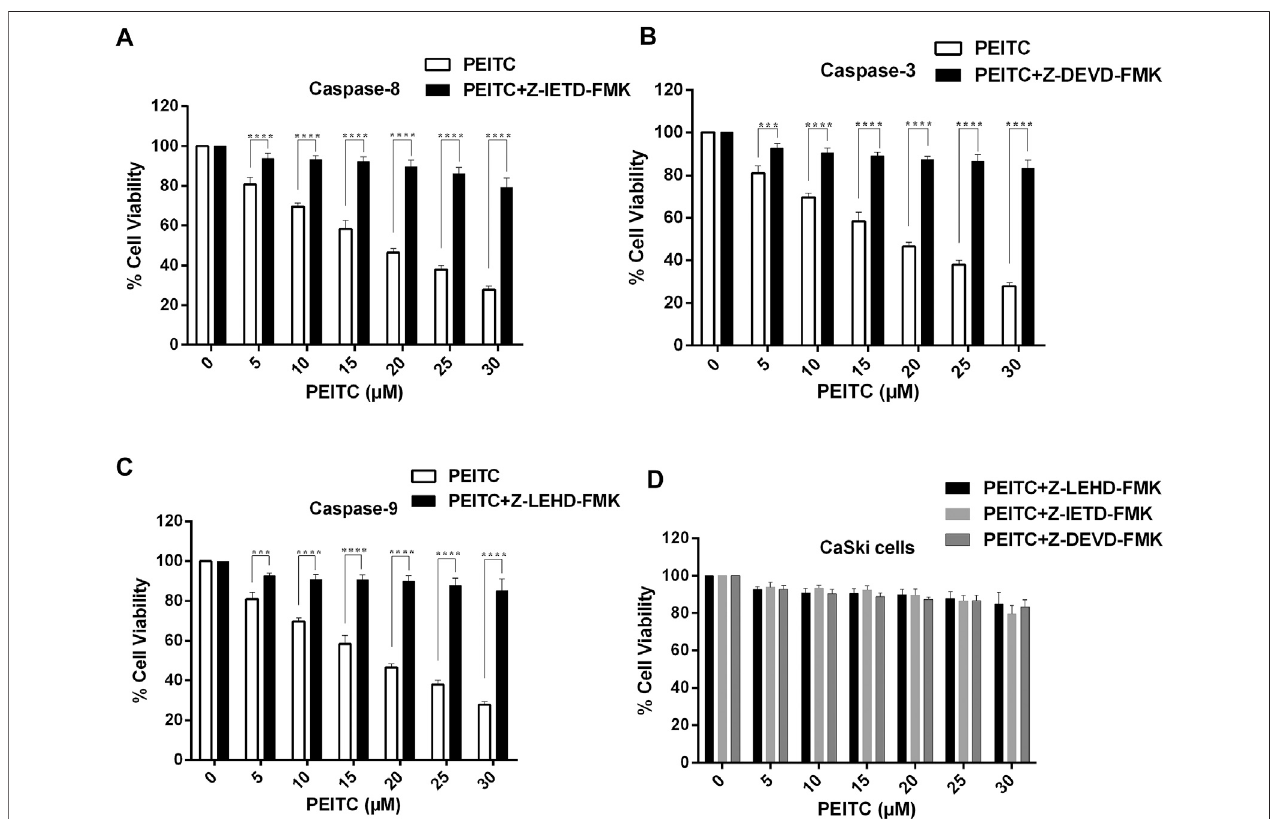
FIGURE5| EffectofPEITConactivationofcaspasesinCaSkicellsasassessedinthepresenceofcaspaseinhibitors.PercentcellviabilityofPEITC-treated(20,25 and 30 μ M) CaSki cell was determined in the presence of caspase inhibitors by MTT assay. (A) Z-DEVD-FMK-caspase-3 inhibitor, (B) Z-IETD-FMK-caspase-8 inhibitor and (C) Z-LEHD-FMK-caspase-9 inhibitor. (D) Combined graph showing percent cell viability of PEITC-treated CaSki cells in the presence of caspase inhibitors. The data represents mean ± SD of three independent experiments. * p value < 0.05 compared with the untreated control was considered statistically signi fi cant.